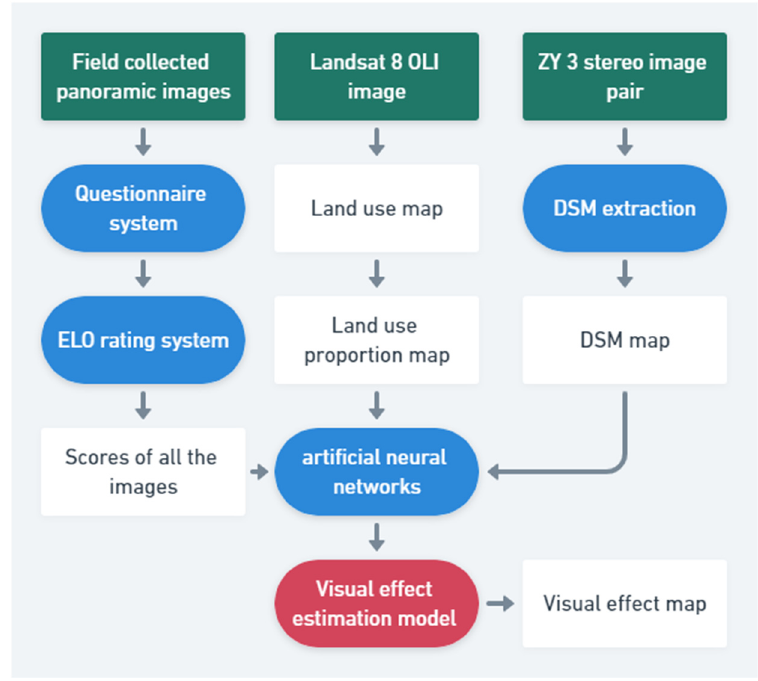
Figure 2. Technology roadmap.